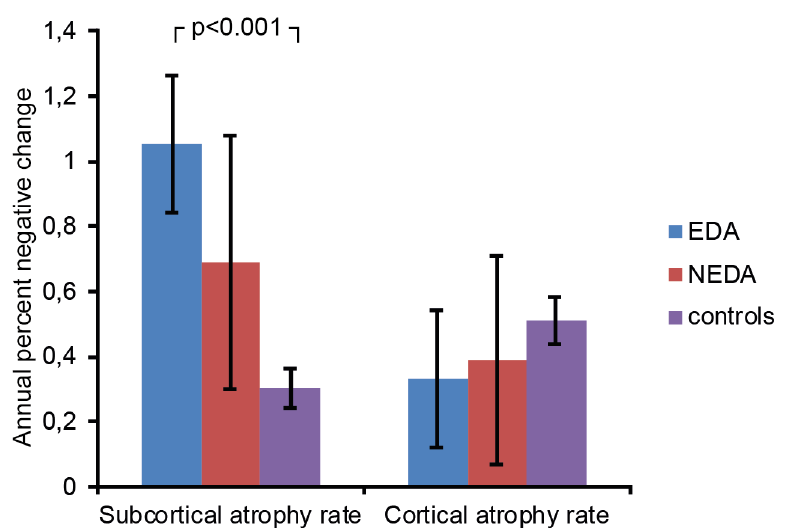
Fig 6. Annual gray matter atrophy rates. ANOVAs with Bonferroni-corrected post-hoc tests revealed that subcortical annual atrophy rates differed between patients with evidence of disease activity and healthy controls. Patients with no evidence of disease activity had similar atrophy rates as controls. Cortical atrophy rates were similar in all groups.